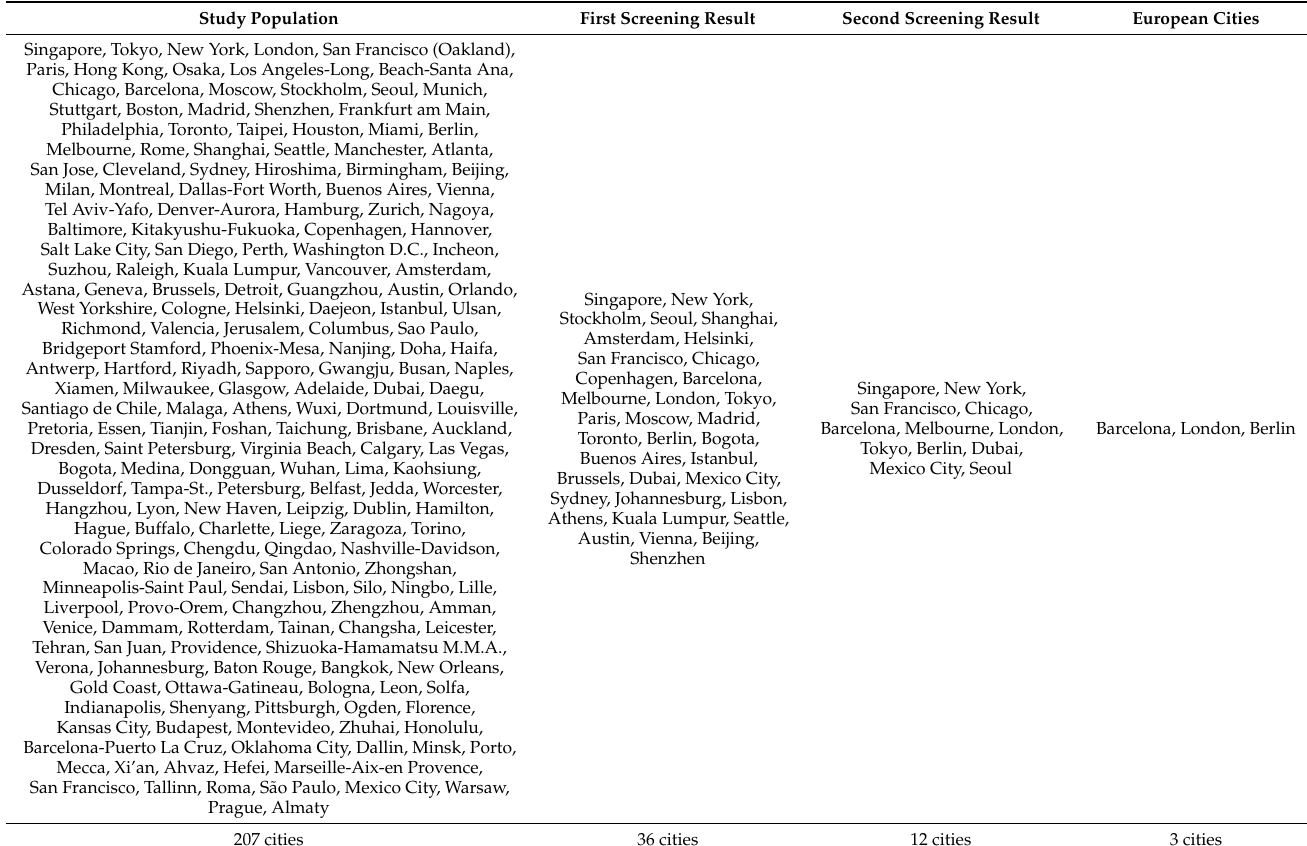
Table 2. A process of sampling